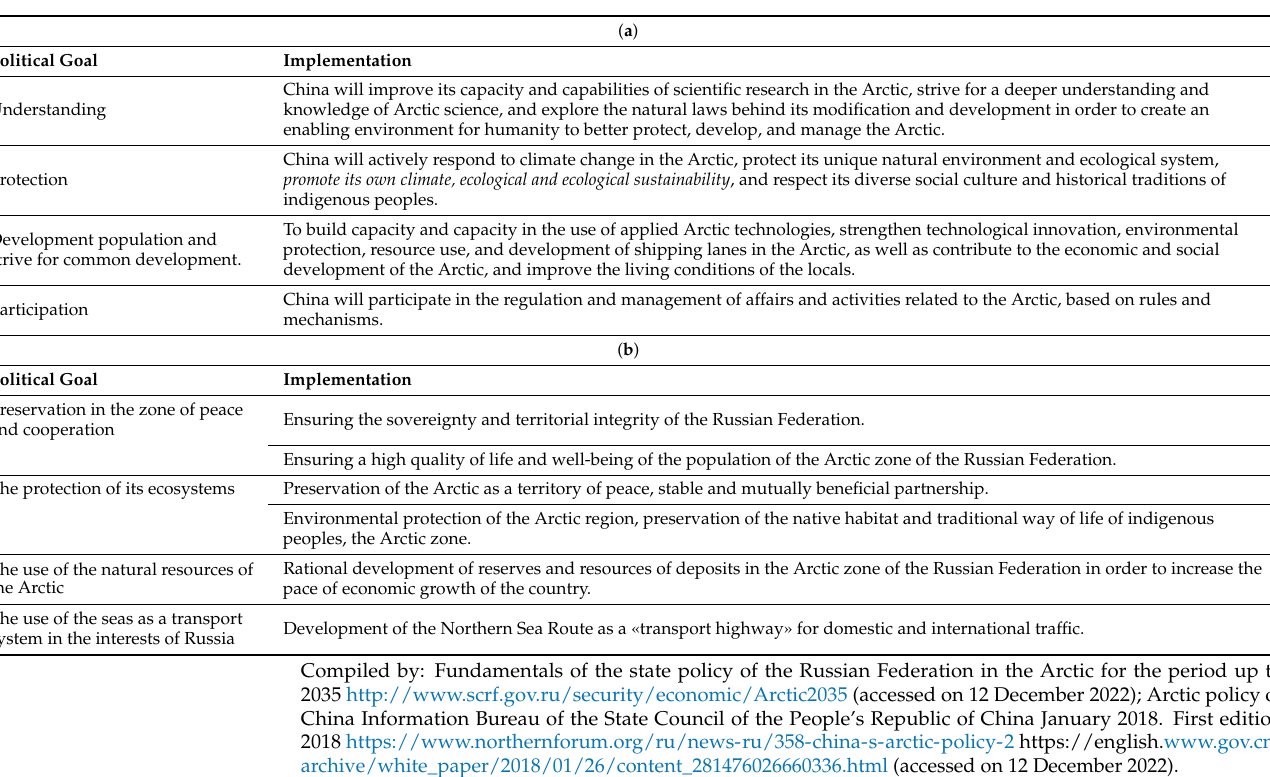
Table 5. ( a ) The national interests of China in the Arctic region. ( b ) The national interests of the Russian Federation in the Arctic